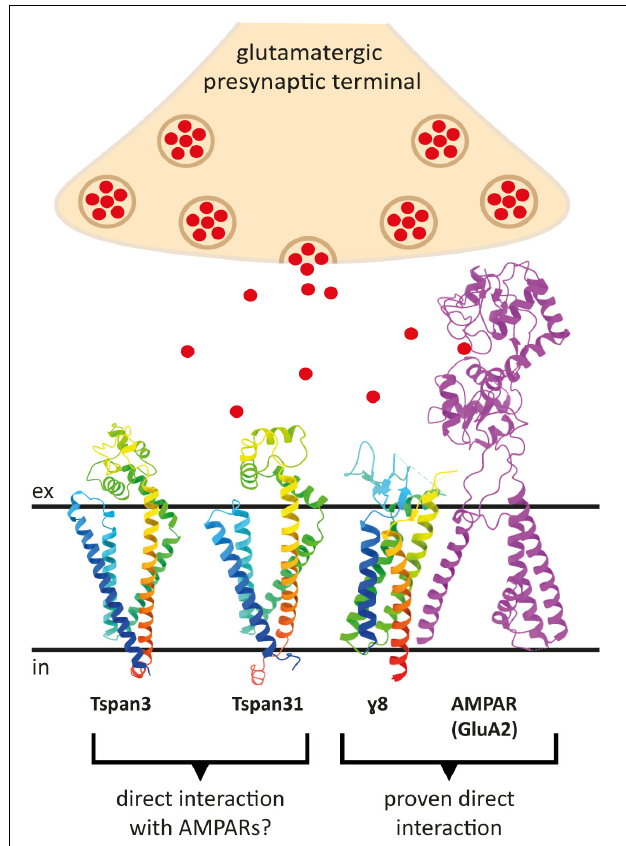
FIGURE 10 | Putative direct interactions of tetraspanins with AMPARs at the postsynaptic membrane of a glutamatergic synapse. Shown is a GluA2 subunit in the D position in magenta, which has been proven to interact with the TARP γ 8 (in rainbow colors) (right). To the left are the AlphaFold prediction models of Tspan3 and Tspan31, also colored in rainbow colors, which may also affect AMPAR function in a TARP-like manner. Red dots represent glutamate molecules. The proteins are displayed in ribbon style. The AMPAR subunit GluA2 lacks the C-terminus as well as the amino terminal domain (ATD) (PDB model: 7LEP) (Yu J. et al.,